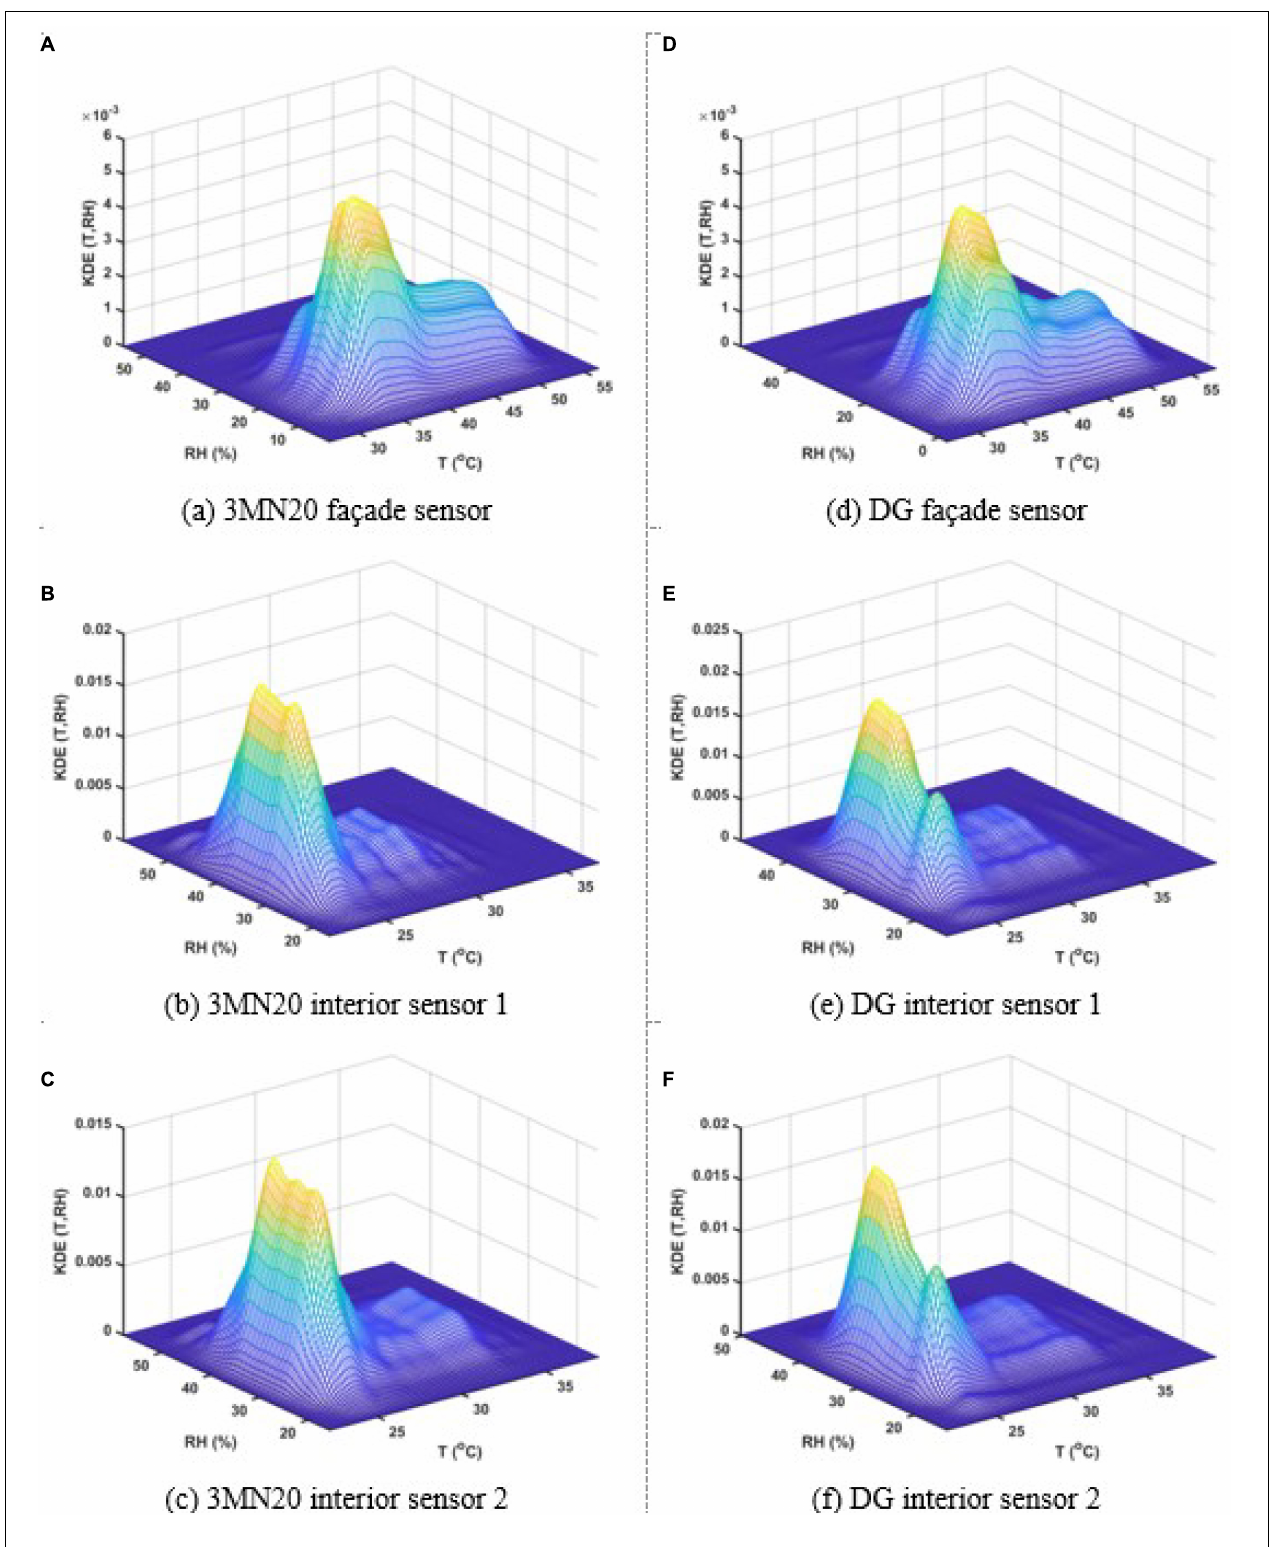
FIGURE 10 | Combined kernel density estimation (KDE) of temperature (T) and relative humidity (RH) for three DHT22 sensors on the façade and interior wall surface of offices during the month of June 2019; (A–C) 3MN20 windows, and (D–F) DG windows.